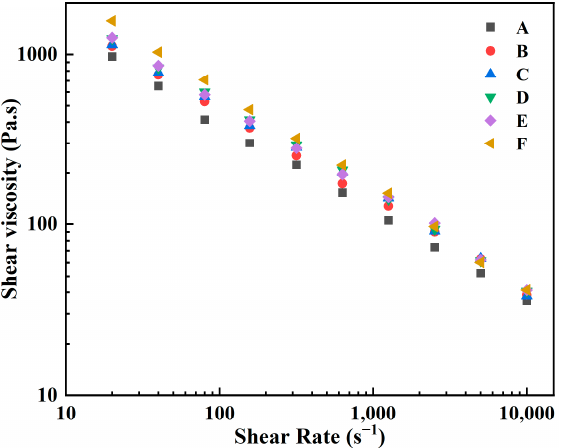
Figure 3. Rheological characteristics of samples A–F with different coupling media.